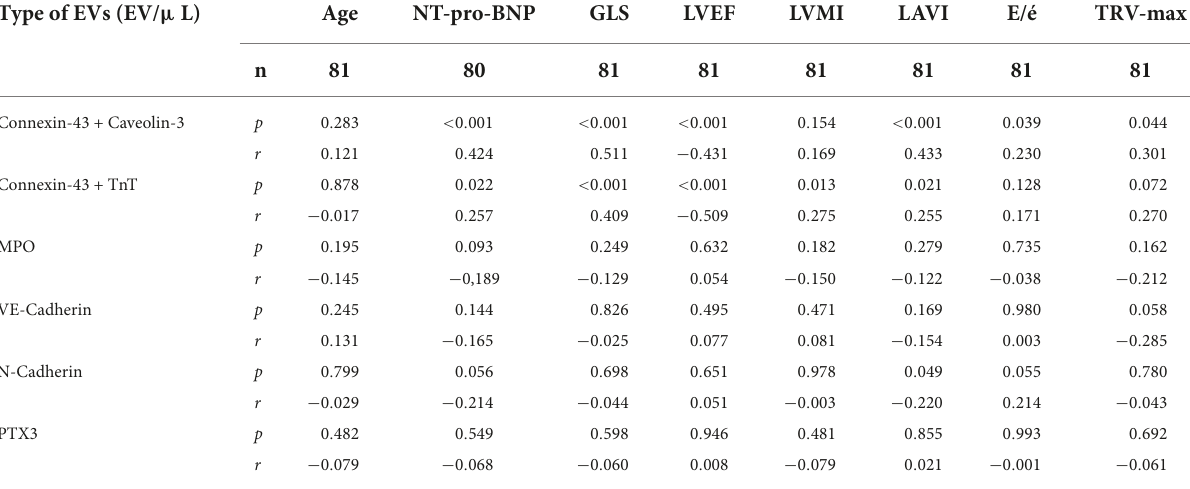
TABLE 2 Correlations between extracellular vesicles in plasma samples from coronary sinus and preoperative clinical/echocardiographic parameters in all patients, irrespective of heart failure phenotype. Type of EVs (EV/ µ